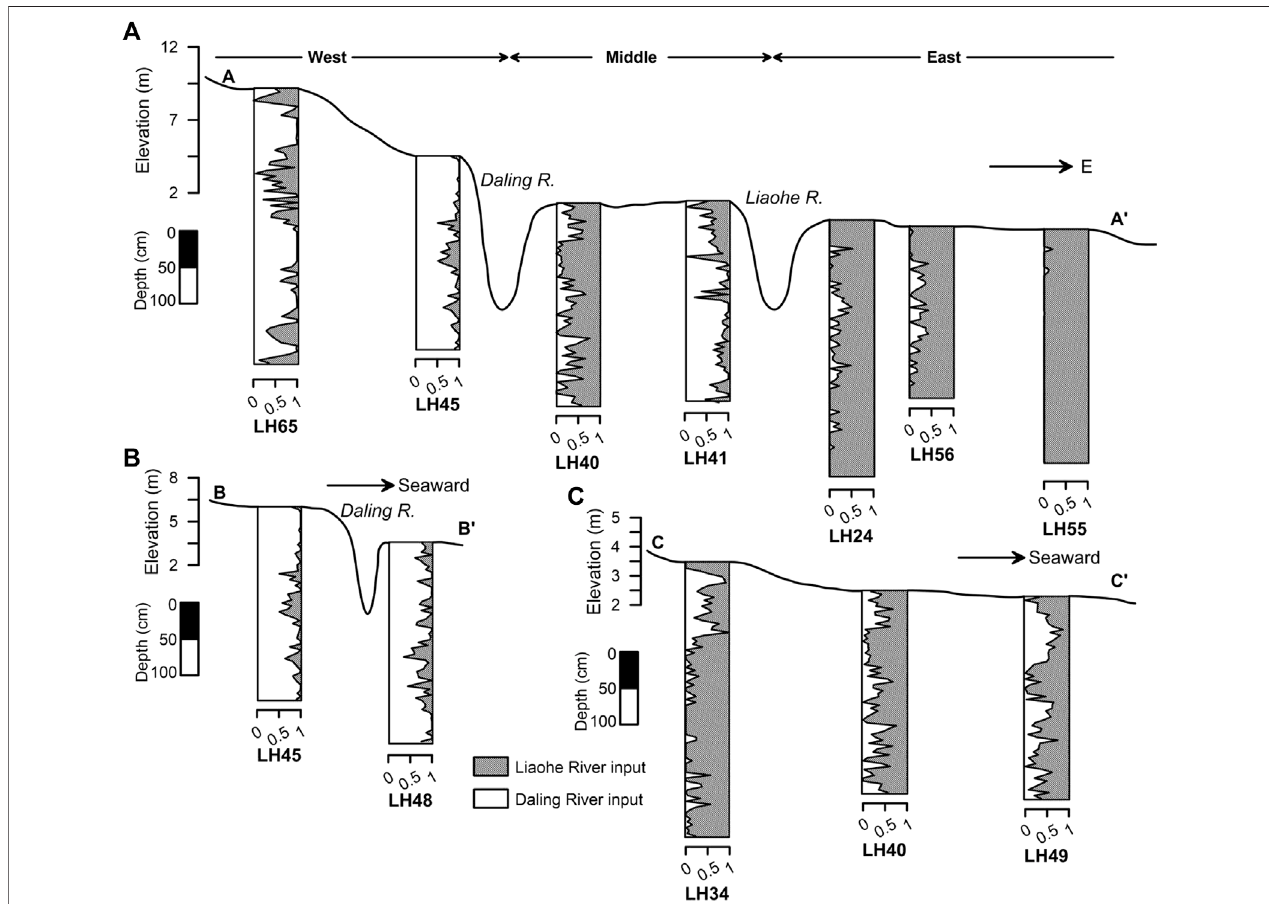
FIGURE 8 | Contribution of the Daling and Liaohe rivers to the fi ne-grained sediments in the NBC determined by the non-linear model.